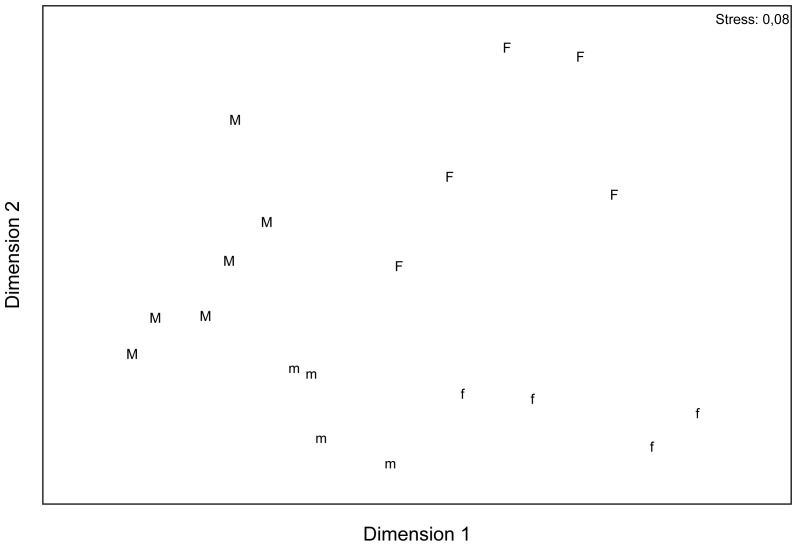
Nonmetric multidimensional scaling (NMDS) of floral scent composition (percentage amount) in Salix caprea.Female and male individuals of Salix caprea were sampled in situ in 2006 (F: females 2006, M: males 2006). Cut twigs were used in 2007 (f: females 2007, m: males 2007). Close samples (individuals) were similarly scented, whereas distant samples emitted a quite different scent pattern.